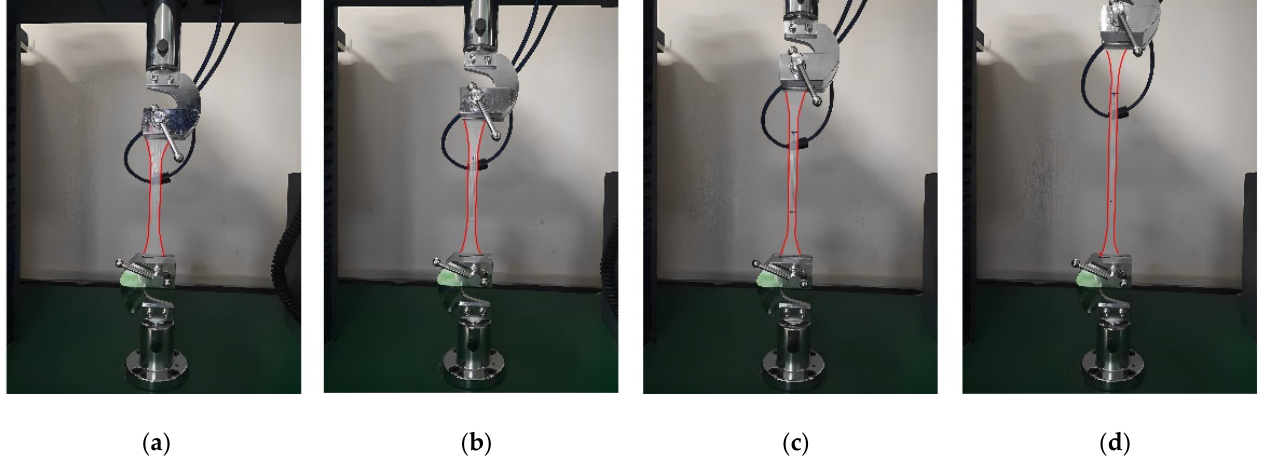
Figure 4. Process of the tensile test of film. ( a ) shows the state of the sample after prestressing, ( b – d ) show the tensile process of the sample after loading. ( b – d ) show the tensile process of the sample after